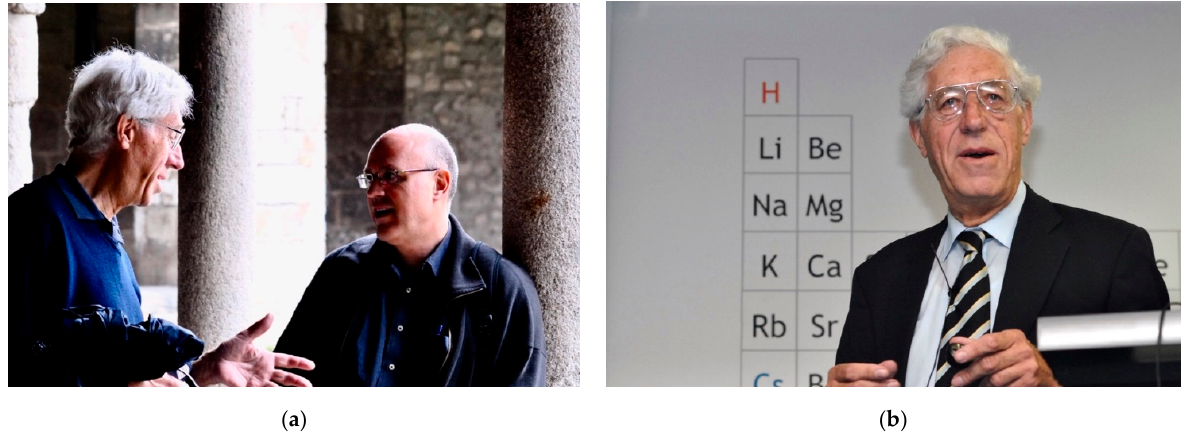
Figure 4. ( a ) Peter Day and Agustí Nieto ‐ Galán during a visit to the cathedral of La Seu d’Urgell, 5 June 2008, ( b ) Day lecturing on the history of magnetism at the University of Barcelona. 8 October 2008. Photos by S. Alvarez.